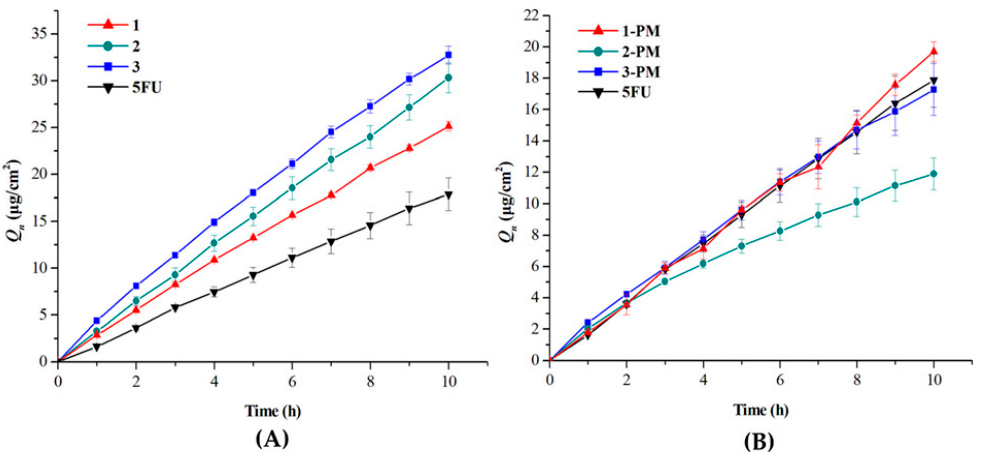
Figure 9. Cumulative amount permeated for ( A ) Cocrystal, ( B ) Physical mixtures of 5-fluorouracil. Reprinted (adapted) with permission from [78]. Copyright (2016) American Chemical Society.